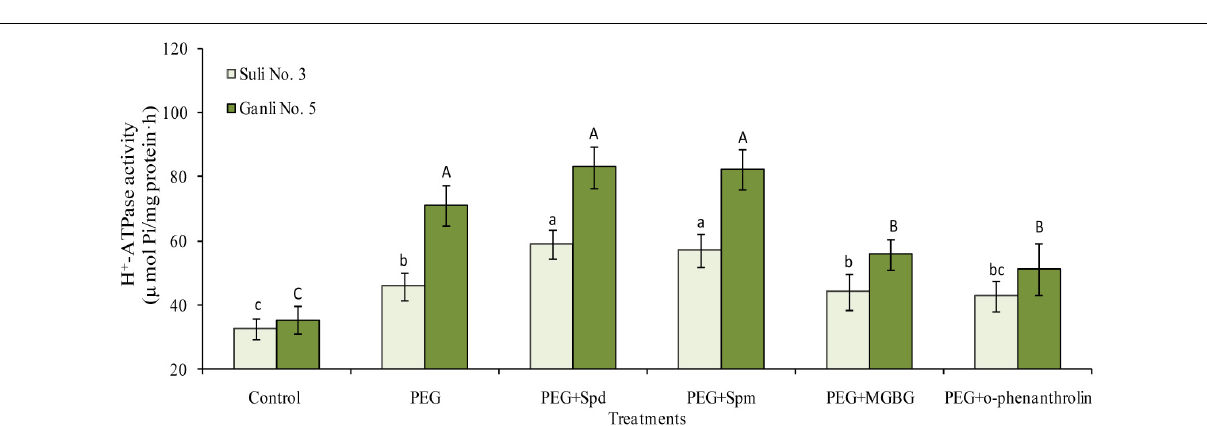
FIGURE 8 | Changes in the activity of root plasma membrane H + -ATPase of plum seedlings under PEG, exogenous Spd, Spm, MGBG, and o-phenanthroline. Control: treatment without PEG or the other reagents (–0.15 MPa); PEG: treatment with PEG (–0.85 MPa); PEG + Spd: treatment with PEG and Spd (1 mM); PEG + Spm: treatment with PEG and Spm (1 mM); PEG + MGBG: treatment with PEG and MGBG (0.5 mM); PEG + o-phenanthroline: treatment with PEG and o-phenanthroline (0.2 mM). The data here were means ( n = 9) ± standard error of 3 independent experiments. Significant differences between treatments are indicated with letters, with upper and lower letters for each cultivar ( P <